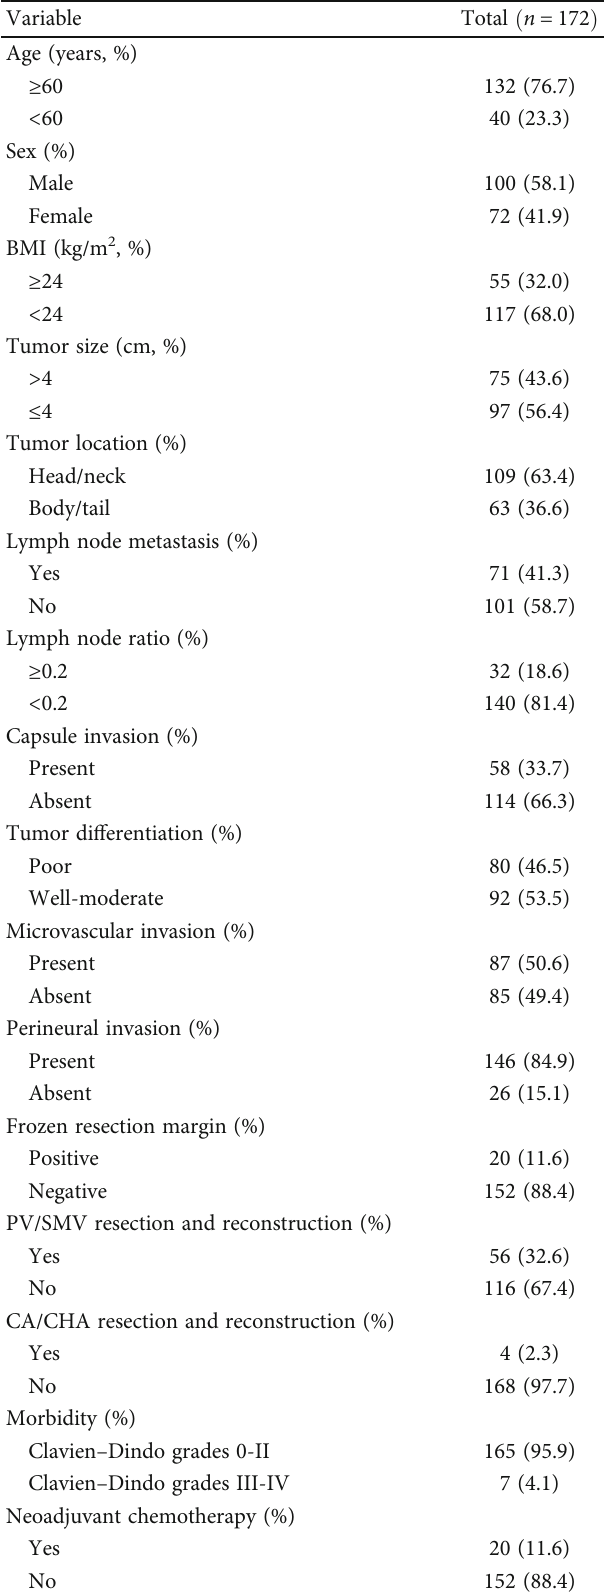
Table 1: Clinicopathological and treatment characteristics of the 172 patients.